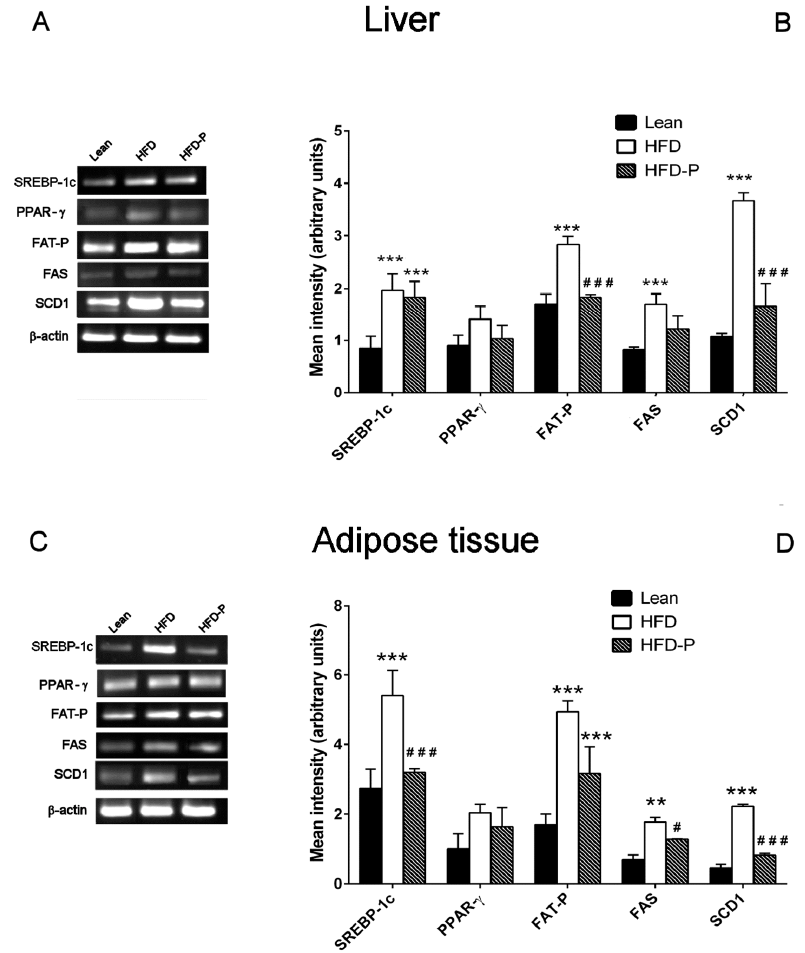
Figure 8. Pistachio consumption reduces the upregulated expression of genes involved in lipid metabolism. Representative images of the RT-PCR results (left panel) and mRNA levels of SREBP - 1c , PPAR- γ , FAT-P , FAS , and SCD1 (right panel) in the livers ( A–B ) and adipose tissues ( C–D ) of lean, HFD, and HFD-P mice belonging to the reversal protocol. Data are the means ± S.E.M. ( n = 8/group). Asterisk denotes significant difference compared with the lean group (* p < 0.05; ** p < 0.01; *** p < 0.001); hash denotes significant difference compared with the HFD group ( # p < 0.05; ## p < 0.01; ### p < 0.001).